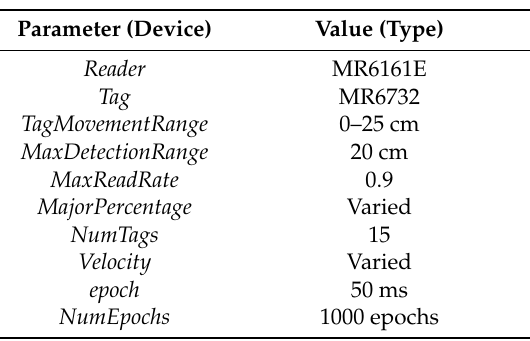
Table 4. Experimental